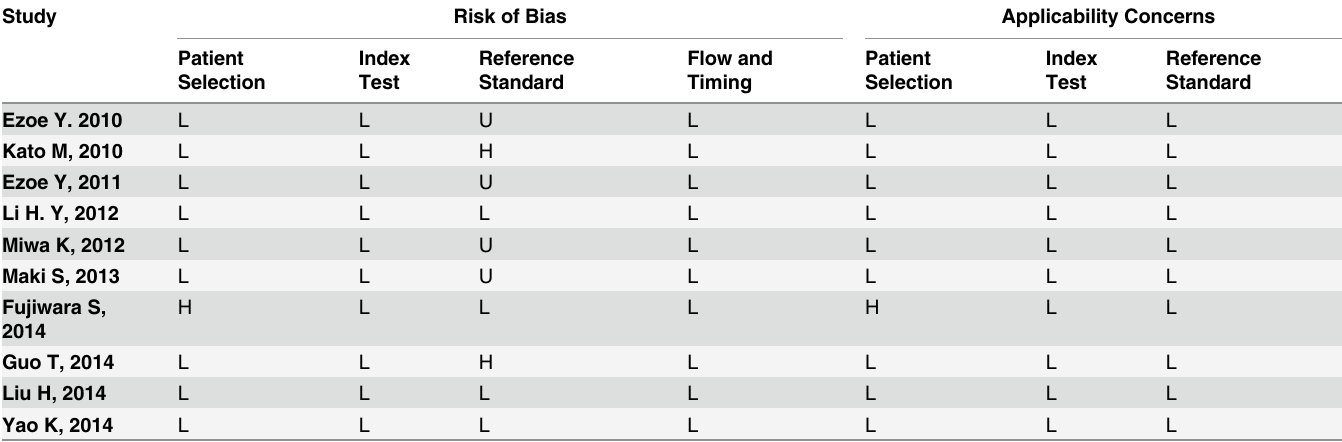
Table 2. Quality assessment of the studies selected for the meta-analysis (QUADAS-2).